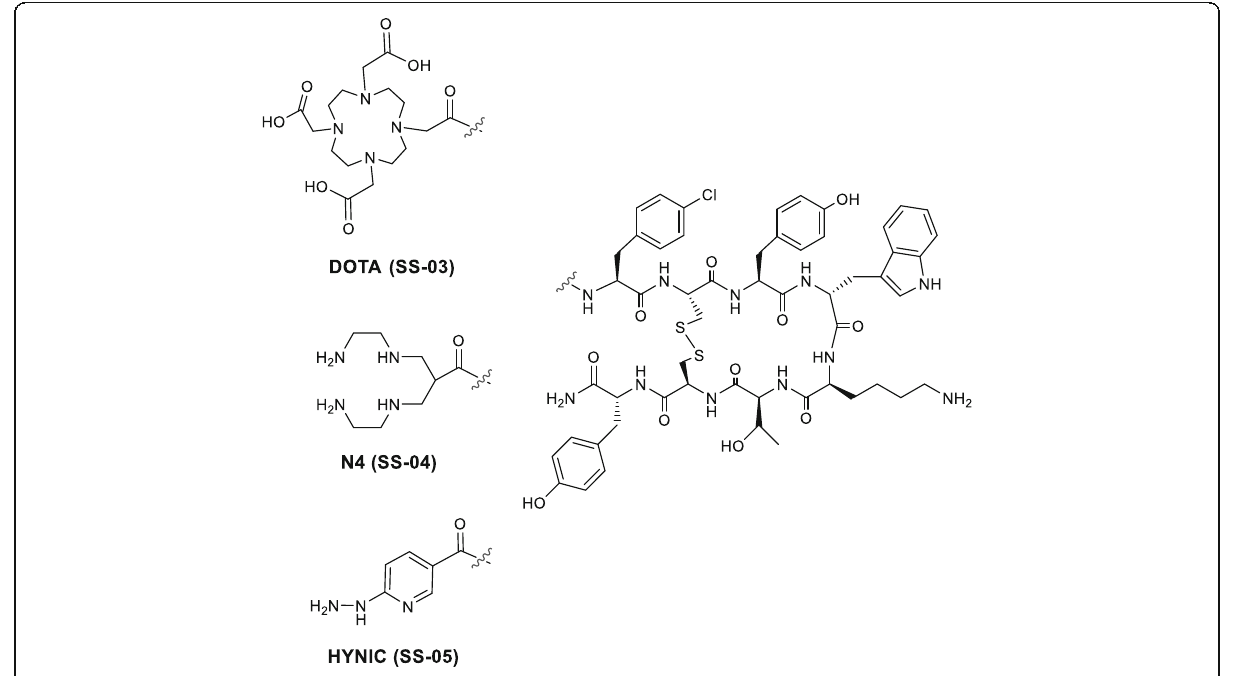
Fig. 1 Structures of the somatostatin receptor subtype 2 antagonist conjugated to different